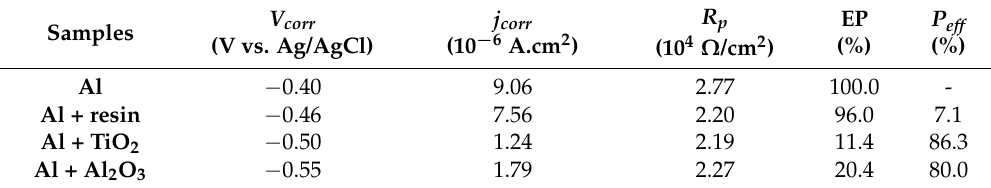
Table 1. Corrosion properties of the studied samples obtained from polarization